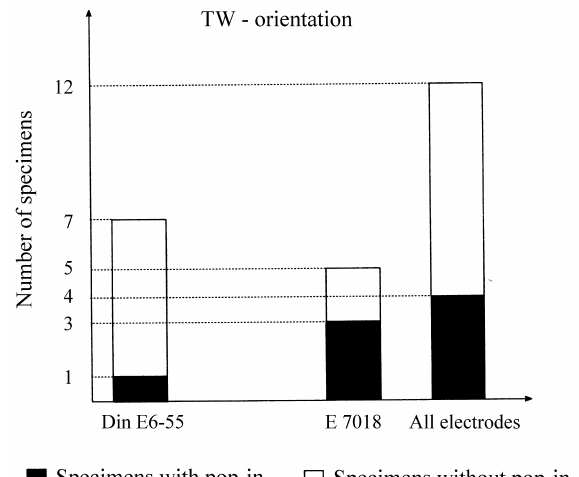
Figure 4. Frequency of pop-in in TW orientation.